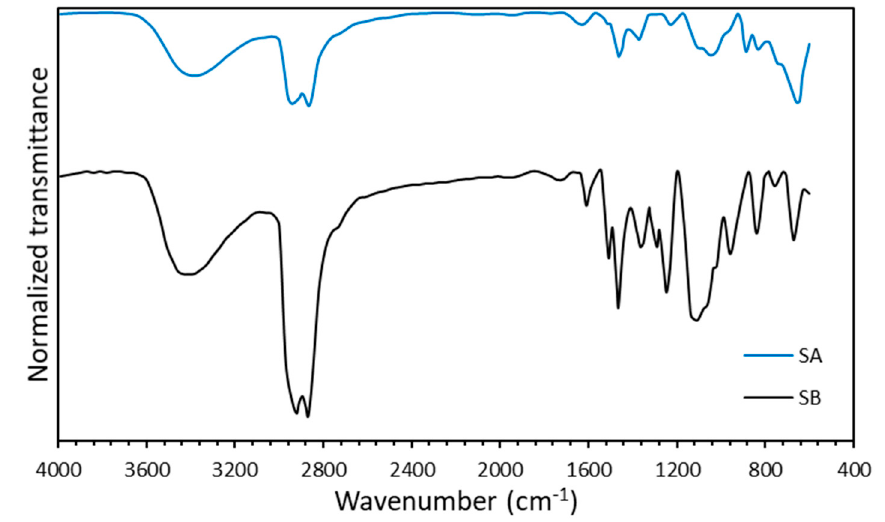
Figure 4. FTIR spectra obtained for the SA and SB